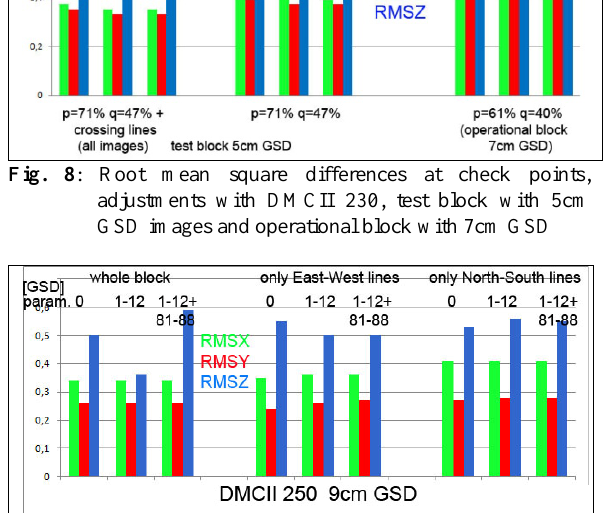
Fig. 9 : Root mean square differences at check points, adjustments with DMCII 250 9cm GSD